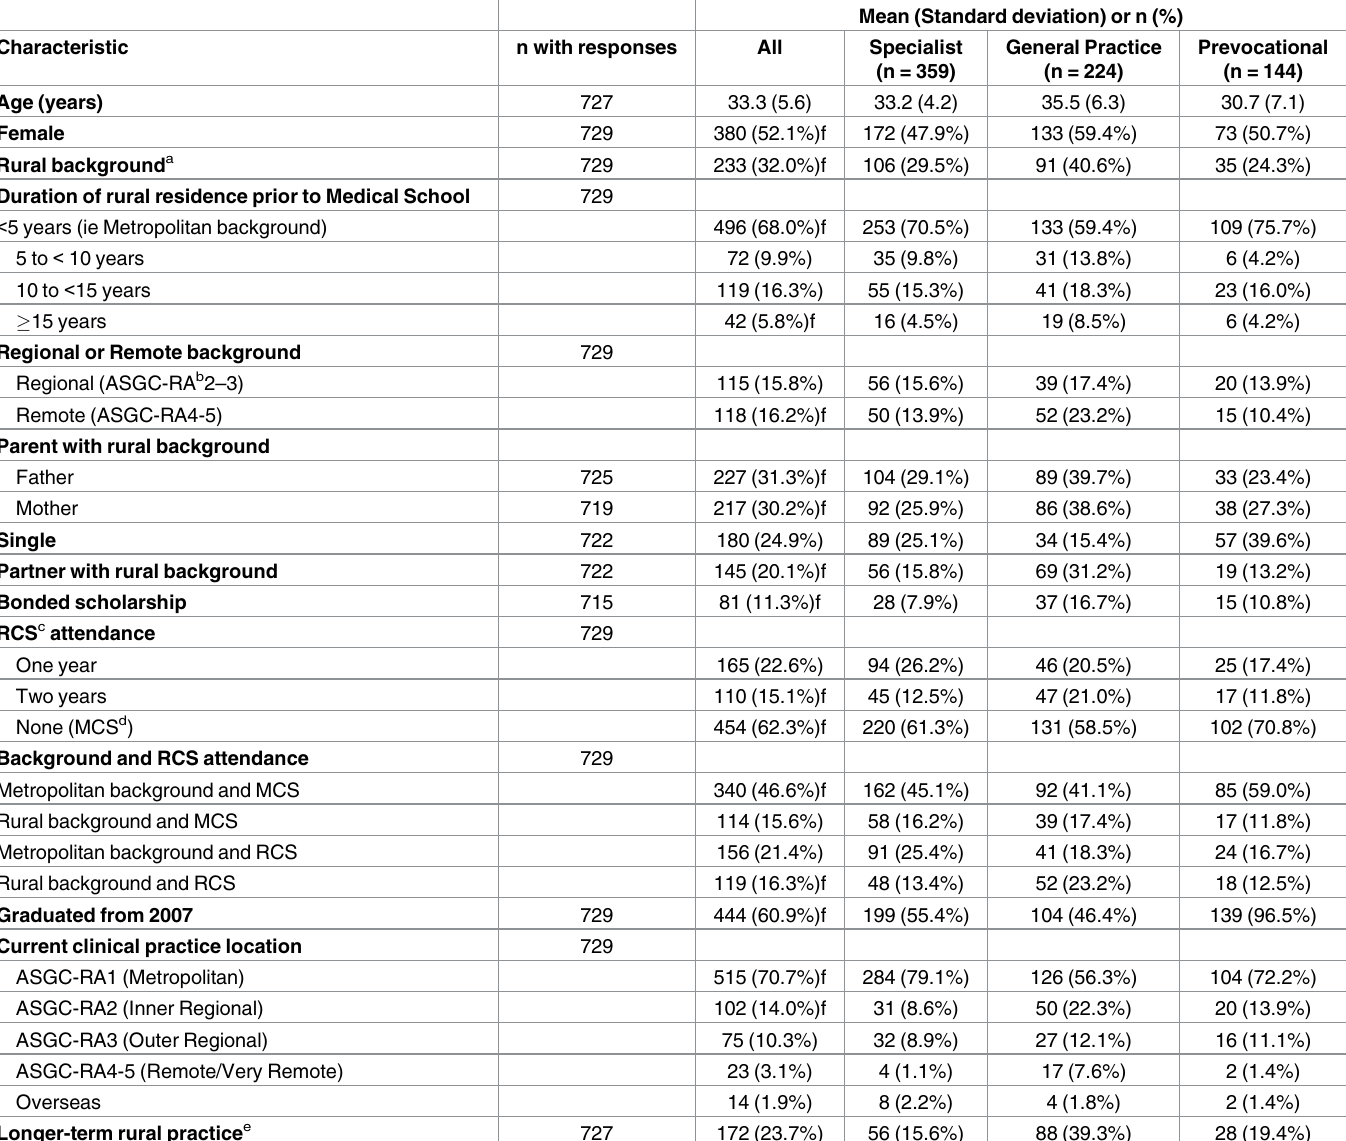
Table 1. Characteristics of participants (n = 729), graduates of The University of Queensland Medical program between 2002–2011.